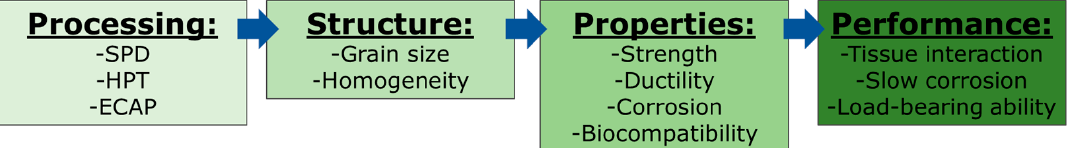
Figure 1. Summary of the relationship between processing, structure, properties and performance of magnesium for biomedical applications.